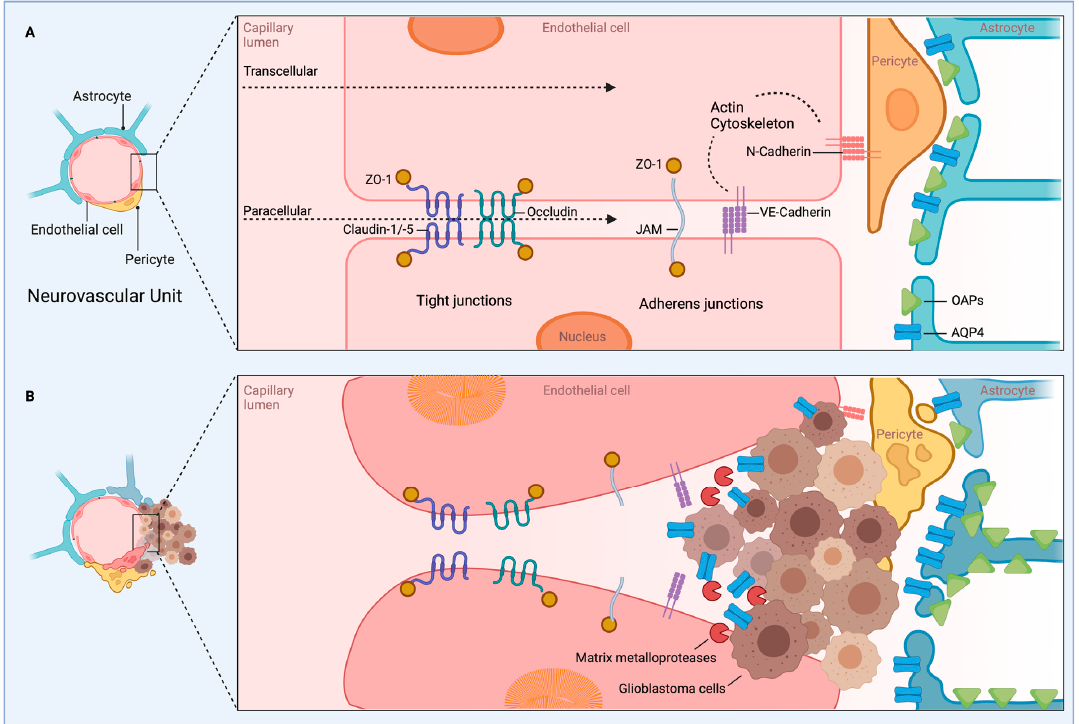
Figure 4. Neurovascular unit (NVU) and blood–brain barrier (BBB) in glioblastoma. ( A ) The NVU provides the structural correlation of the BBB. At the capillary level, the NVU is comprised of endothelial cells connected through tight junctions (TJ) in spatial arrangement with adherens